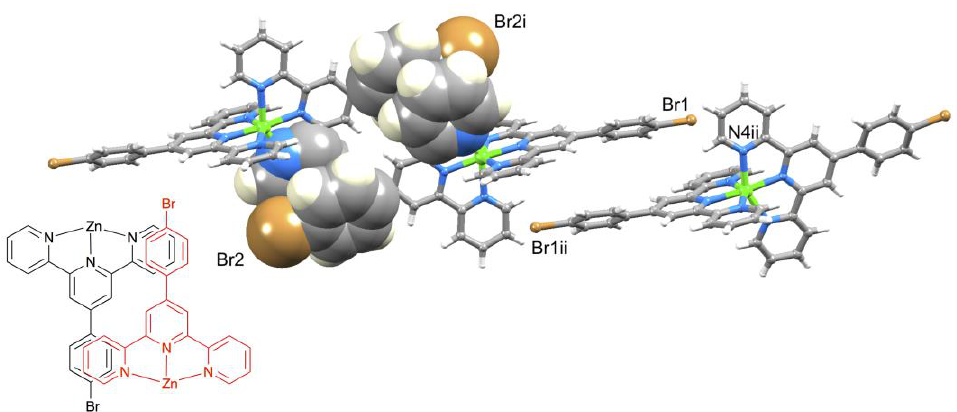
Figure 5. Packing interactions between centrosymmetric pairs of [Zn( 1 ) 2 ] 2+ cations, and schematic representation of the 4 ′ -Phtpy...4 ′ -Phtpy embrace [37,38]. See text for symmetry codes.